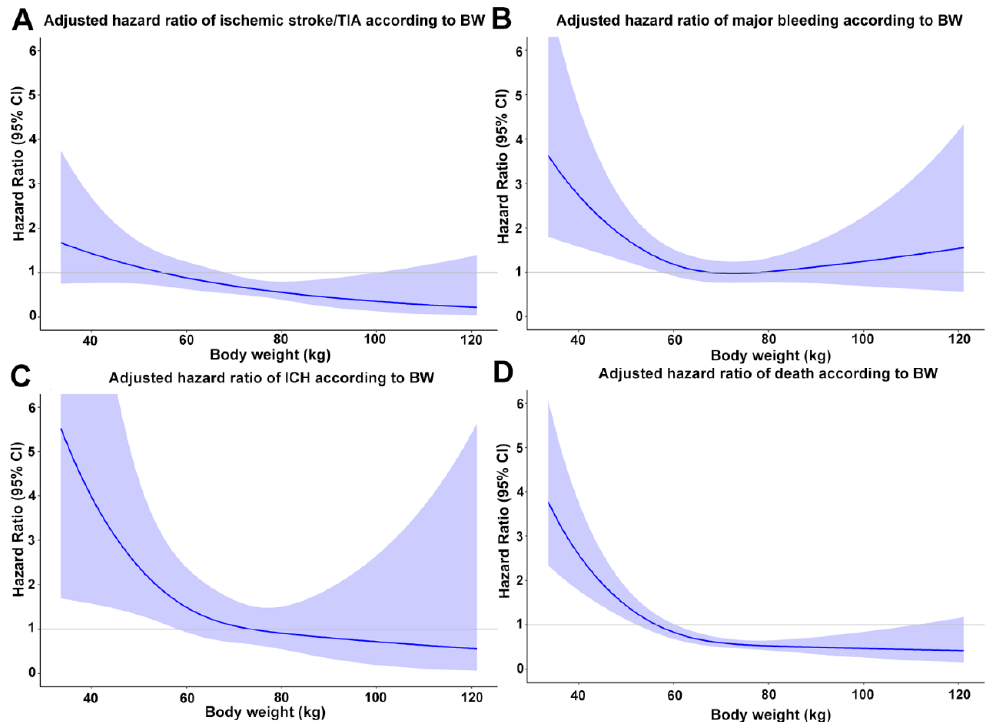
Figure 4. Restricted cubic splines graph showing Hazard ratio (95%CI) of ischemic stroke/transient ischemic attack (TIA) ( A ), major bleeding ( B ), intracerebral hemorrhage (ICH) ( C ), and death ( D ) in patients with different body weight adjusted for age, sex, and comorbid conditions (coronary artery disease, heart failure, smoking status, diabetes, hypercholesterolemia, hypertension, history of ischemic stroke, history of major bleeding, renal replacement therapy, cardiac implantable electronic devices). Cox regression models with restricted cubic splines were used for analysis. CI, confidence interval.